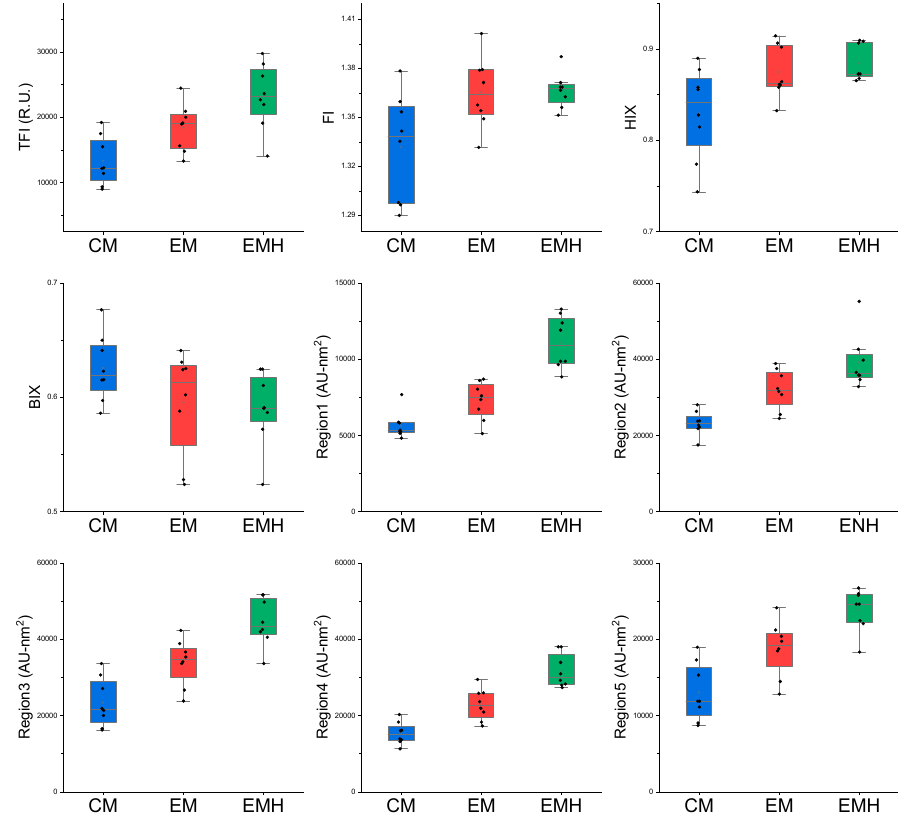
Figure 1. The values of total Fluorescent Intensity (TFI), fluorescent indices and the area volumes of five regions in conventional management (CM), ecological management (EM), and ecological management with hedgerows (EMH) samples.